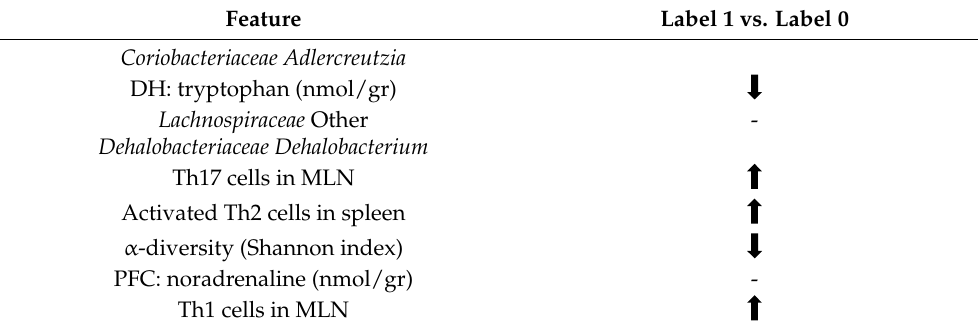
Figure 10. The datasheet of the entire study was analysed regarding marble burying (number of marbles buried) at 8 weeks of age (early adulthood). ( A ) After running the REFS algorithm 10 times, the best signature is at 9 features, with an average global accuracy of all classifiers of 0.73. ( B ) The optimal associated receiver-operating characteristic (ROC) curve for the best-performing classifier Ridge demonstrates an area under the curve (AUC) of 0.84 ± 0.17. ( C ) The 9 features separating the Table 2. Feature reduction in marble burying test (repetitive/anxiety-like behaviour). Table 3. Feature reduction open field test (explorative behaviour).